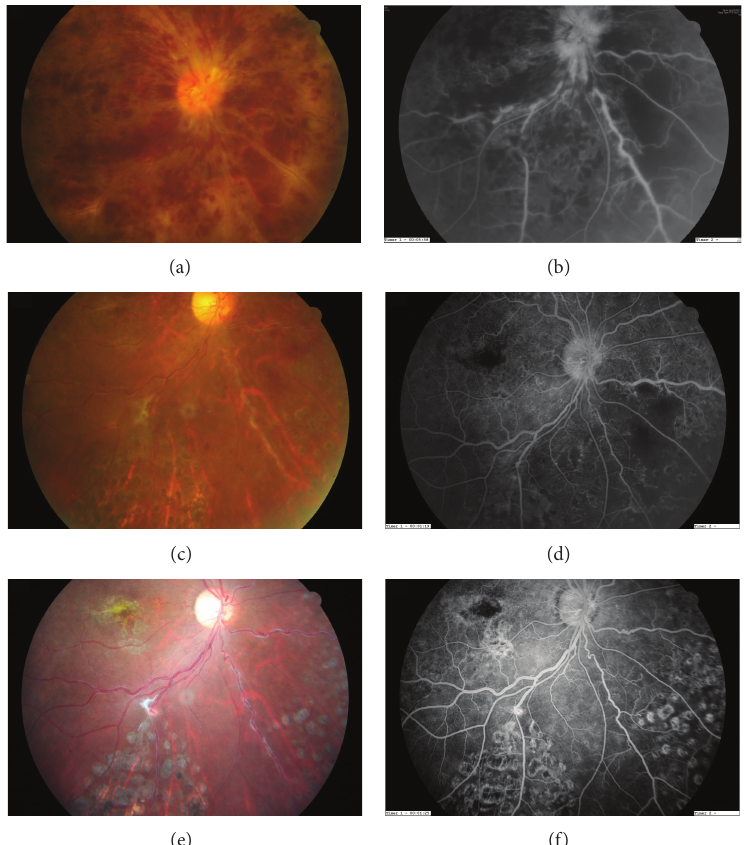
Figure 2: Preoperative color fundus of patient 7 demonstrates diffuse retinal hemorrhage (a). Fluorescein angiography shows a nonperfusion area at the nasal lower retina (b). Color fundus 4 months postoperatively shows a marked decrease in retinal hemorrhage (c); fluorescein angiography demonstrates revascularization toward the originally nonperfused area (d) and retinochoroidal venous anastomosis. Color fundus 4 months postoperatively (e) and fluorescein angiography 18 months later shows almost complete reperfusion of the original ischemic area (f).